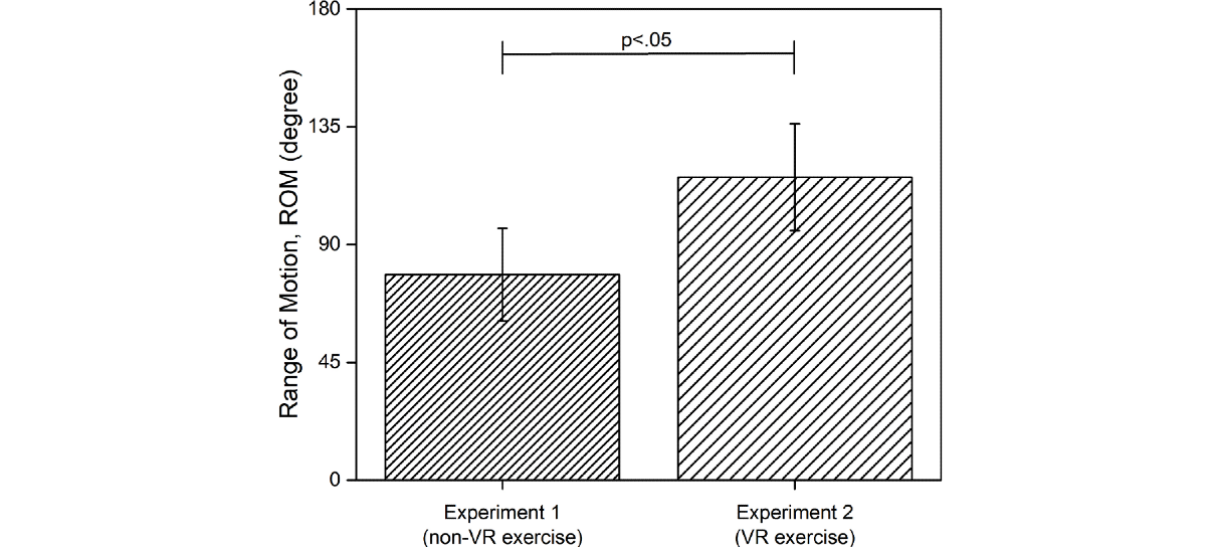
Figure 2. ROM of ankle measured in experiment 1 and experiment 2. VR: virtual